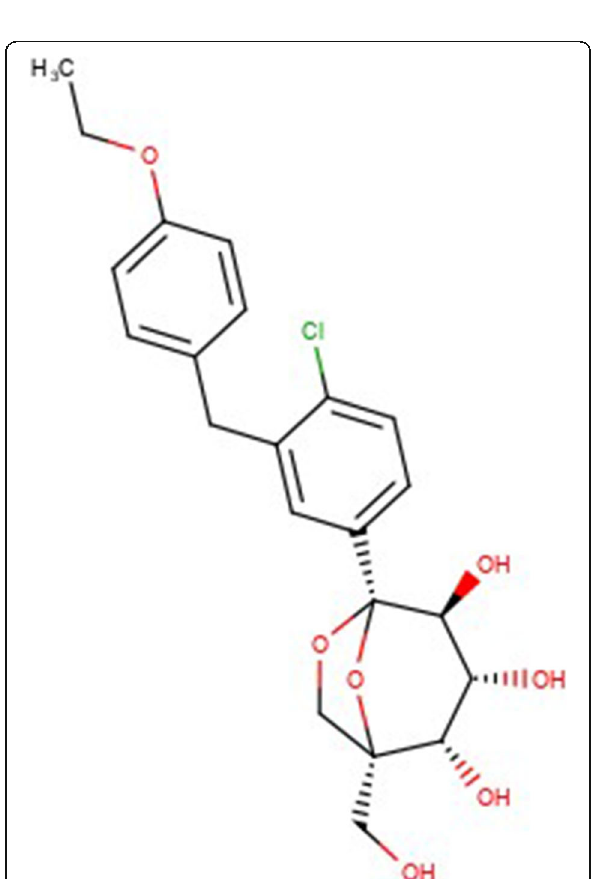
Fig. 2 Chemical structure of